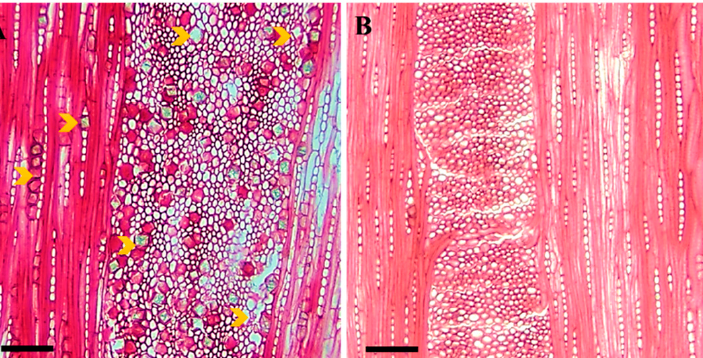
Figure 2. Frequency of crystals in the cells of the ray parenchyma of tangential sections in declined Persian oak wood from two different sampling sites: ( A ) Dareh-shahr, with high numbers, and ( B ) Ilam, with low numbers of crystals. Yellow arrows indicate crystals. Scale bar = 75 μ m.